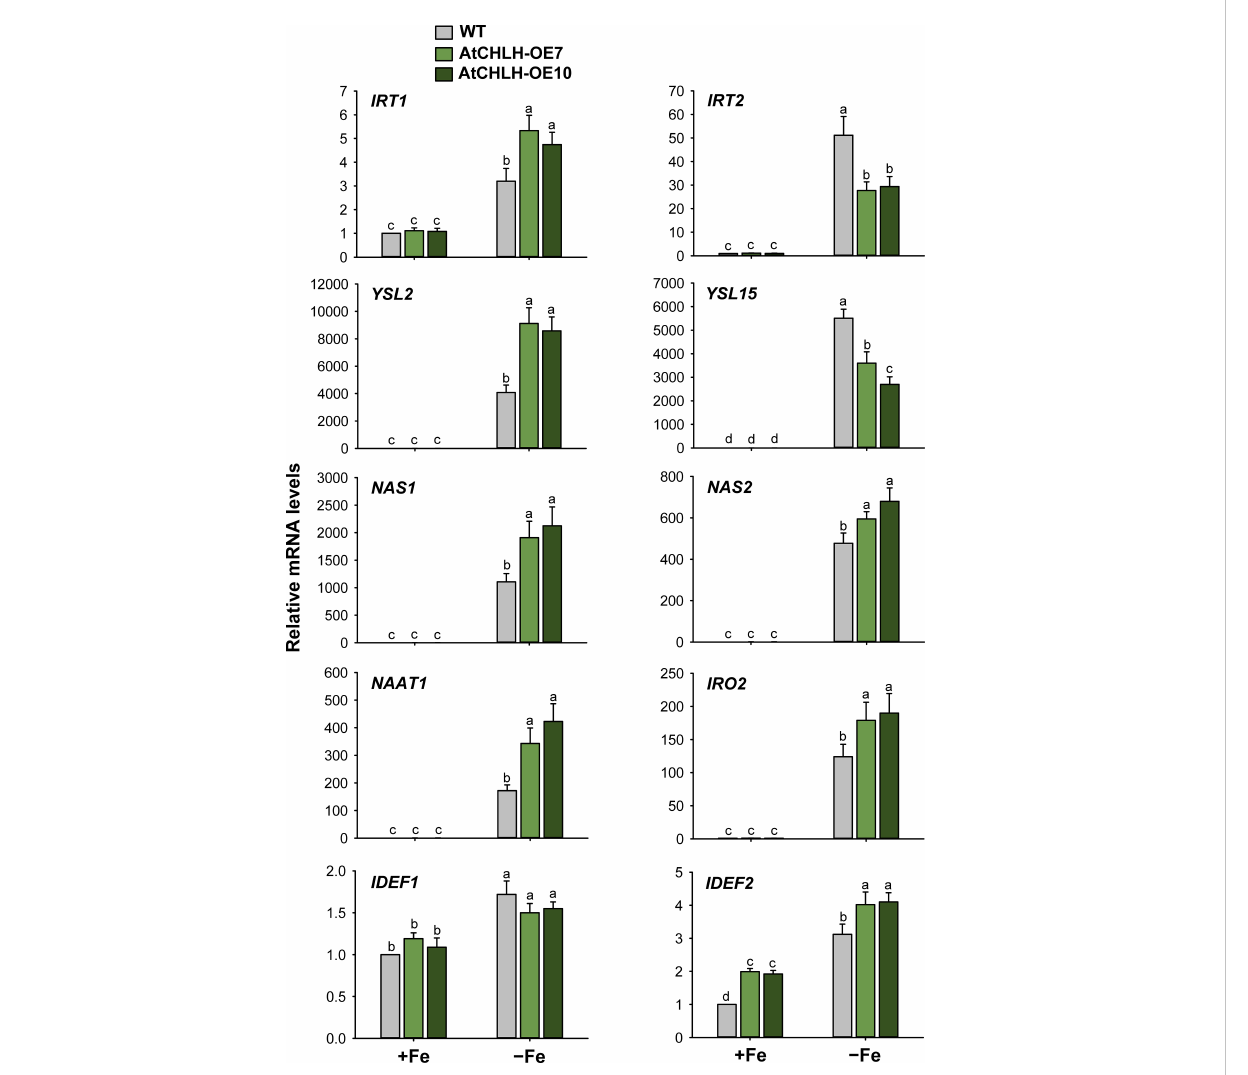
FIGURE 5 Expression of Fe transporter and Fe de fi ciency-induced transcription factor genes in leaves of WT and transgenic plants. The plants were subjected to the same treatments as in Figure 3. Treatment notations are the same as in Figure 3. The general steps performed during the RT-qPCR experiment, from RNA isolation to data analysis, are outlined in Figure 4. Values are means ± SE, and data from three independent experiments are presented. Different letters indicate signi fi cant differences at P < 0.05 by Duncan ’ s multiple range